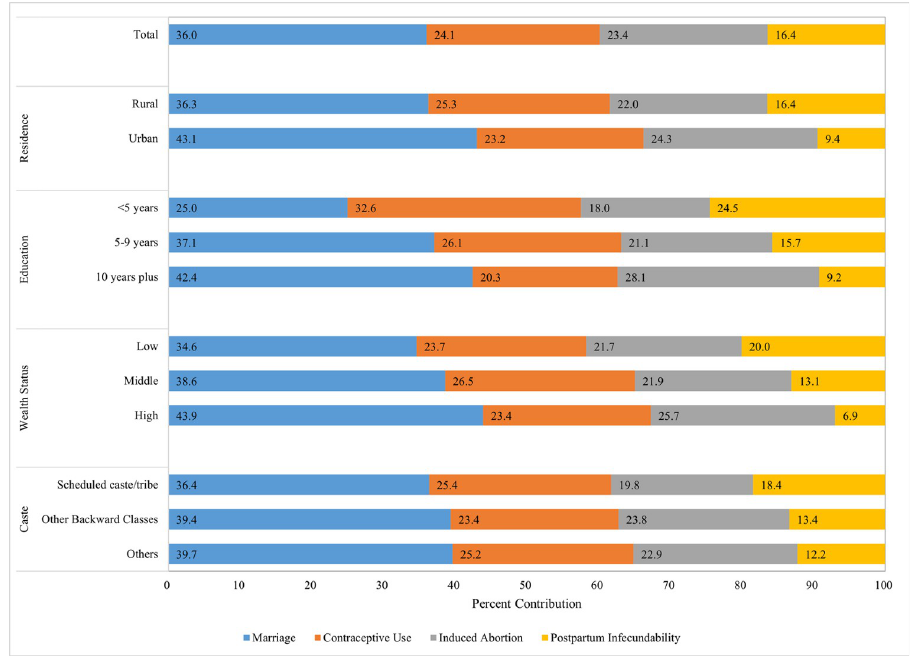
Fig 3. Fertility inhibiting effect of marriage increases, while that of postpartum infecundability decreases with improvements in sociodemographic status, India, 2015–16.